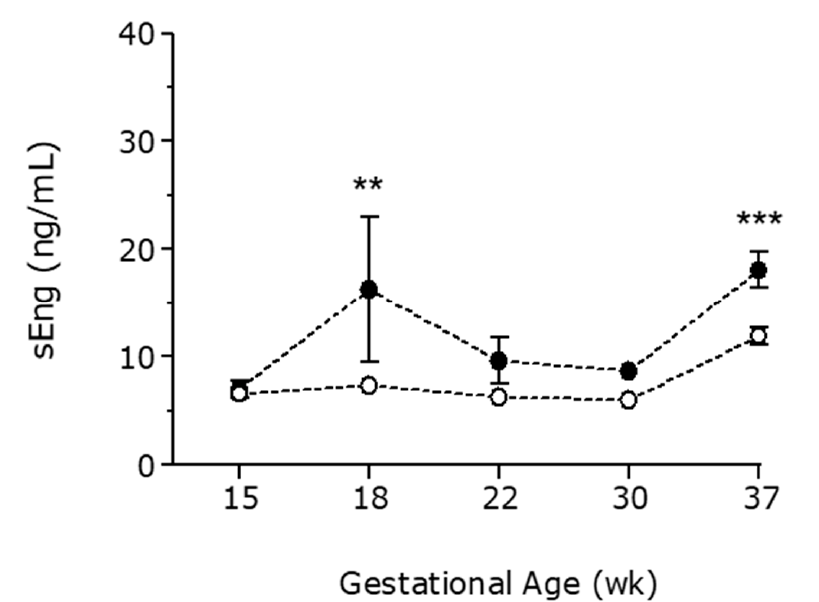
Figure 4. Maternal plasma concentrations of soluble endogline (sEng) in the control group (white points) and pregnant women affected by breast cancer (black points). Differences were analyzed by two-way analysis of variance. Data are presented as mean with SEM. **, p < 0.01; ***, p < 0.001.